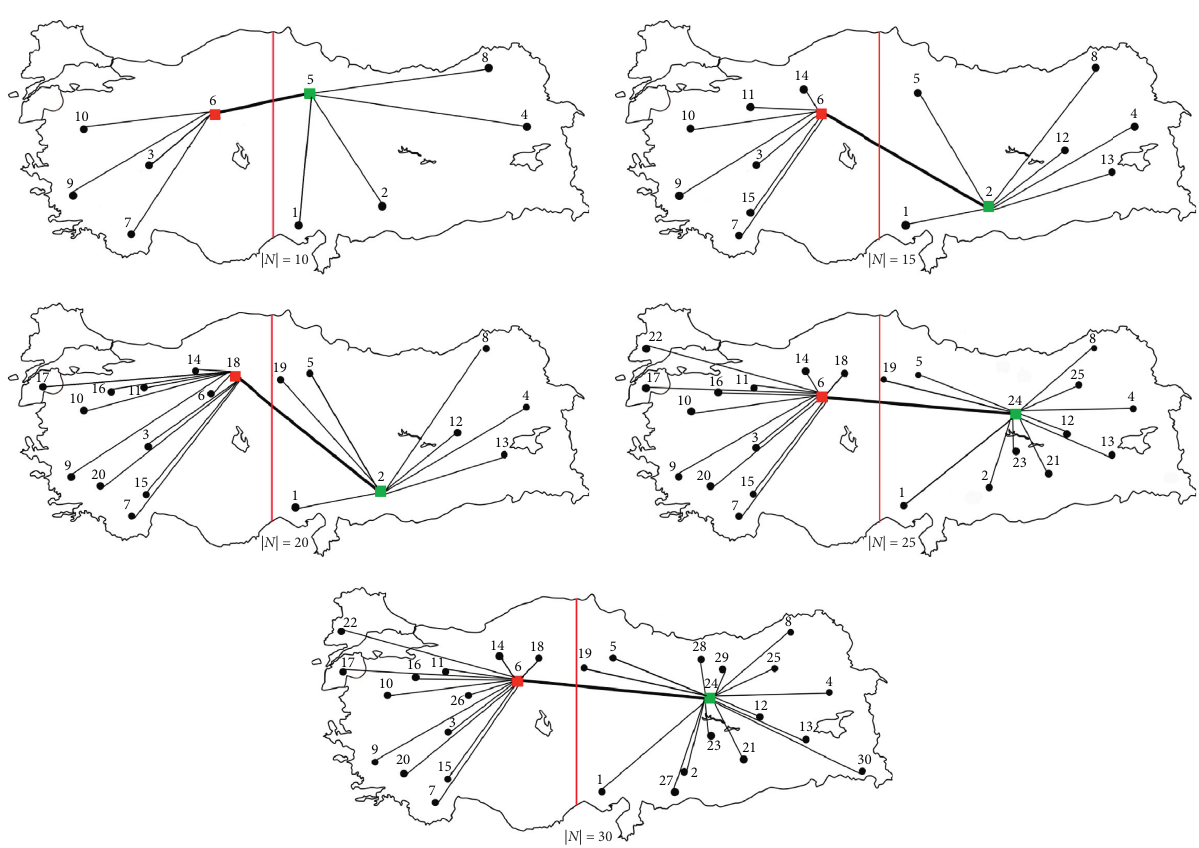
Figure 6: Optimal network topology. Table 6: Computational results for the Turkish network with | N | � 50 and | N | �